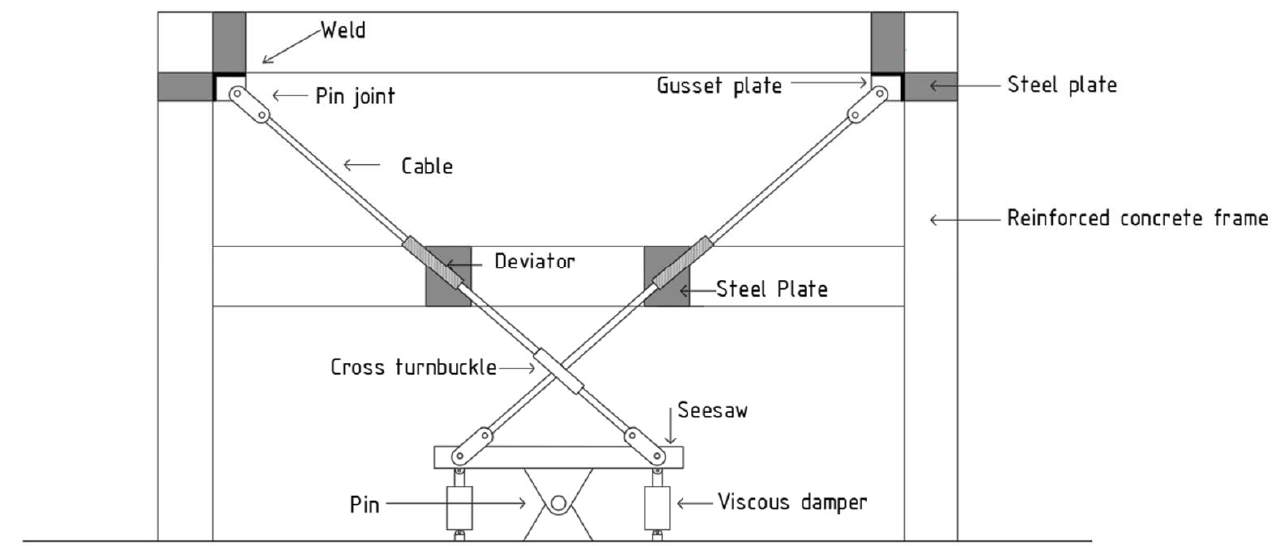
Figure 2. Installation and connection details of a seesaw system eccentrically placed with respect to an RC frame.